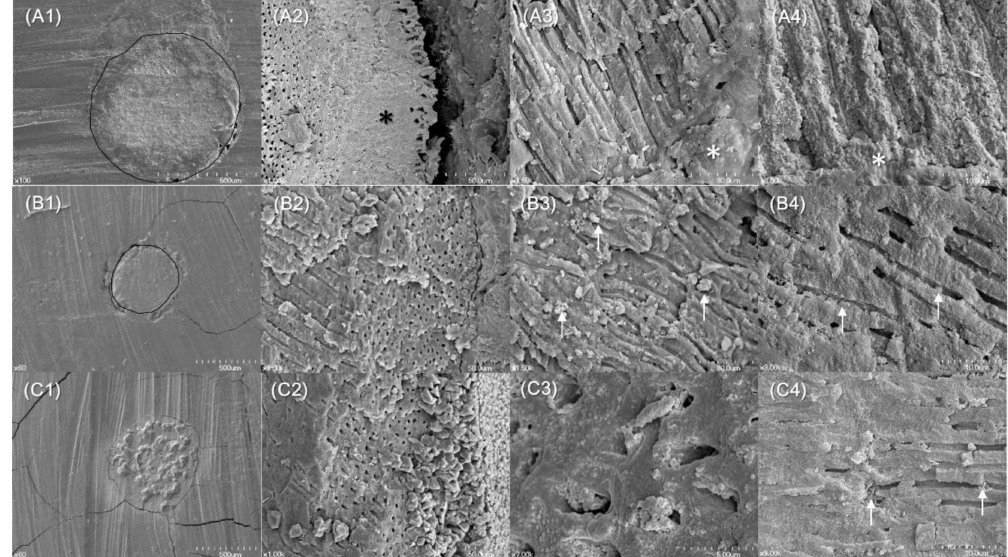
Figure 3. Scanning electron microscopic images of gutta-percha and AH 26 sealer ( A ), gutta-percha and EndoSequence BC sealer ( B ) and CaZrO 3 -containing calcium silicate cements ( C ) filled root canals of human